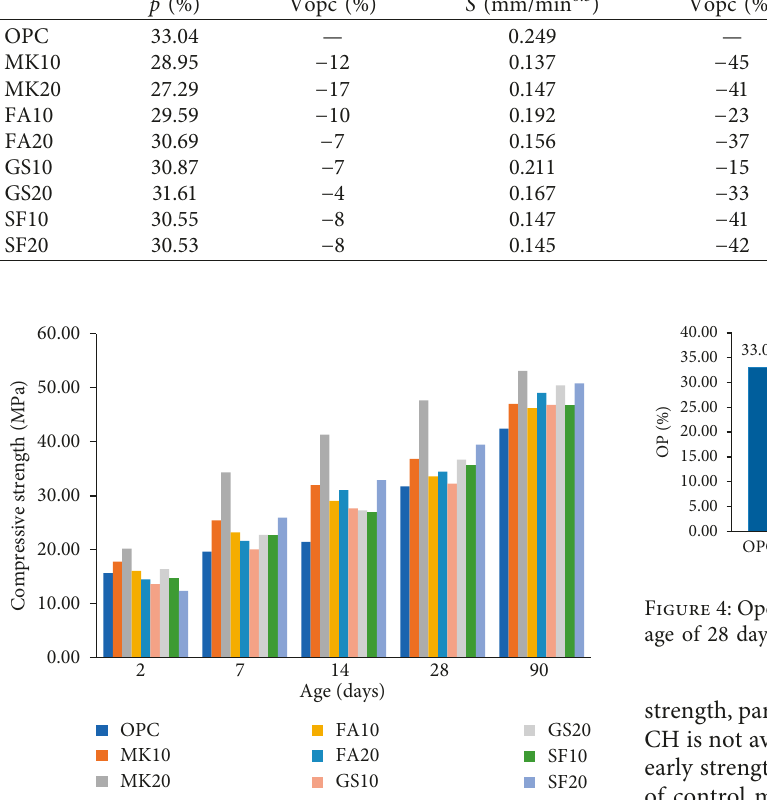
Figure 3: Compressive strength results of mortars containing SCM, at different curing dates.